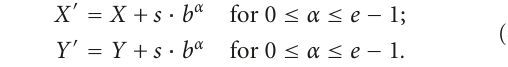
Figure 8: Course of various MNs using the SIMMd